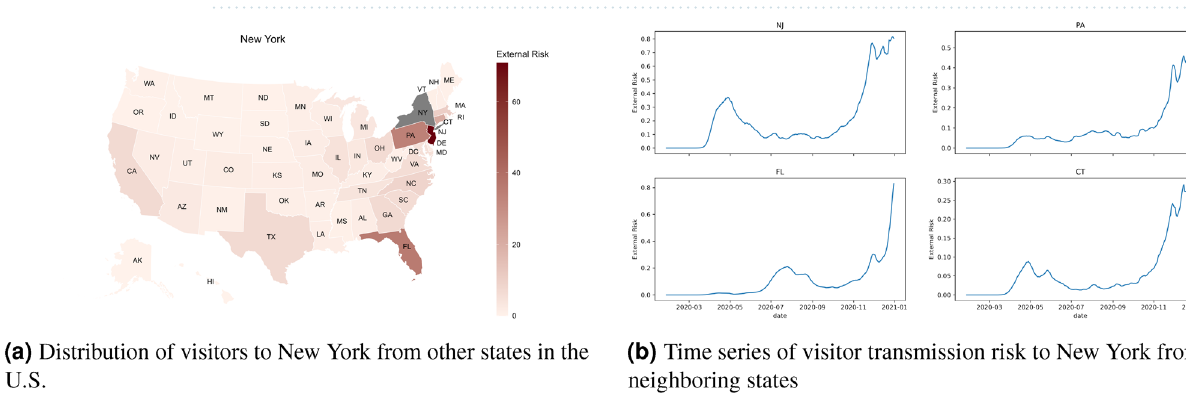
Figure 4. Visitor transmission risk and mobility patterns to the state of New York from other states in the United States. Map generated using urbnmapr 33 .